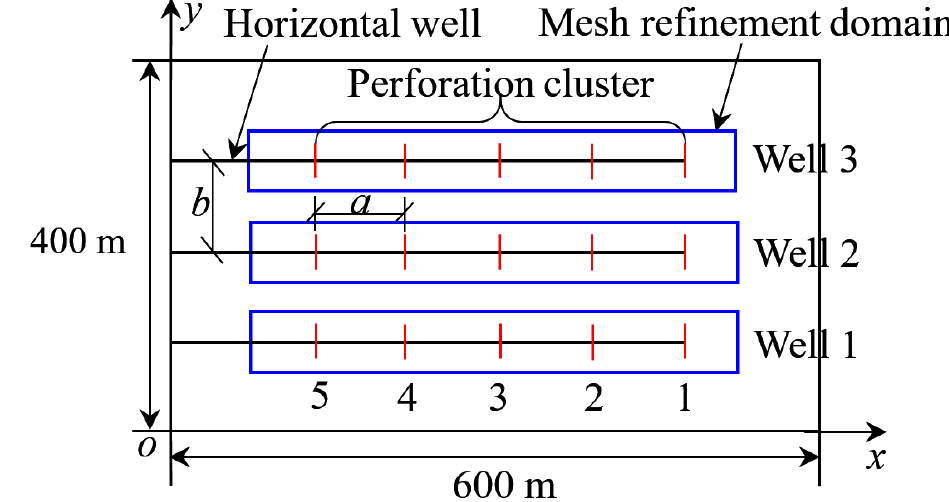
Figure 4. Geometric model of multi-well multistage fracturing.